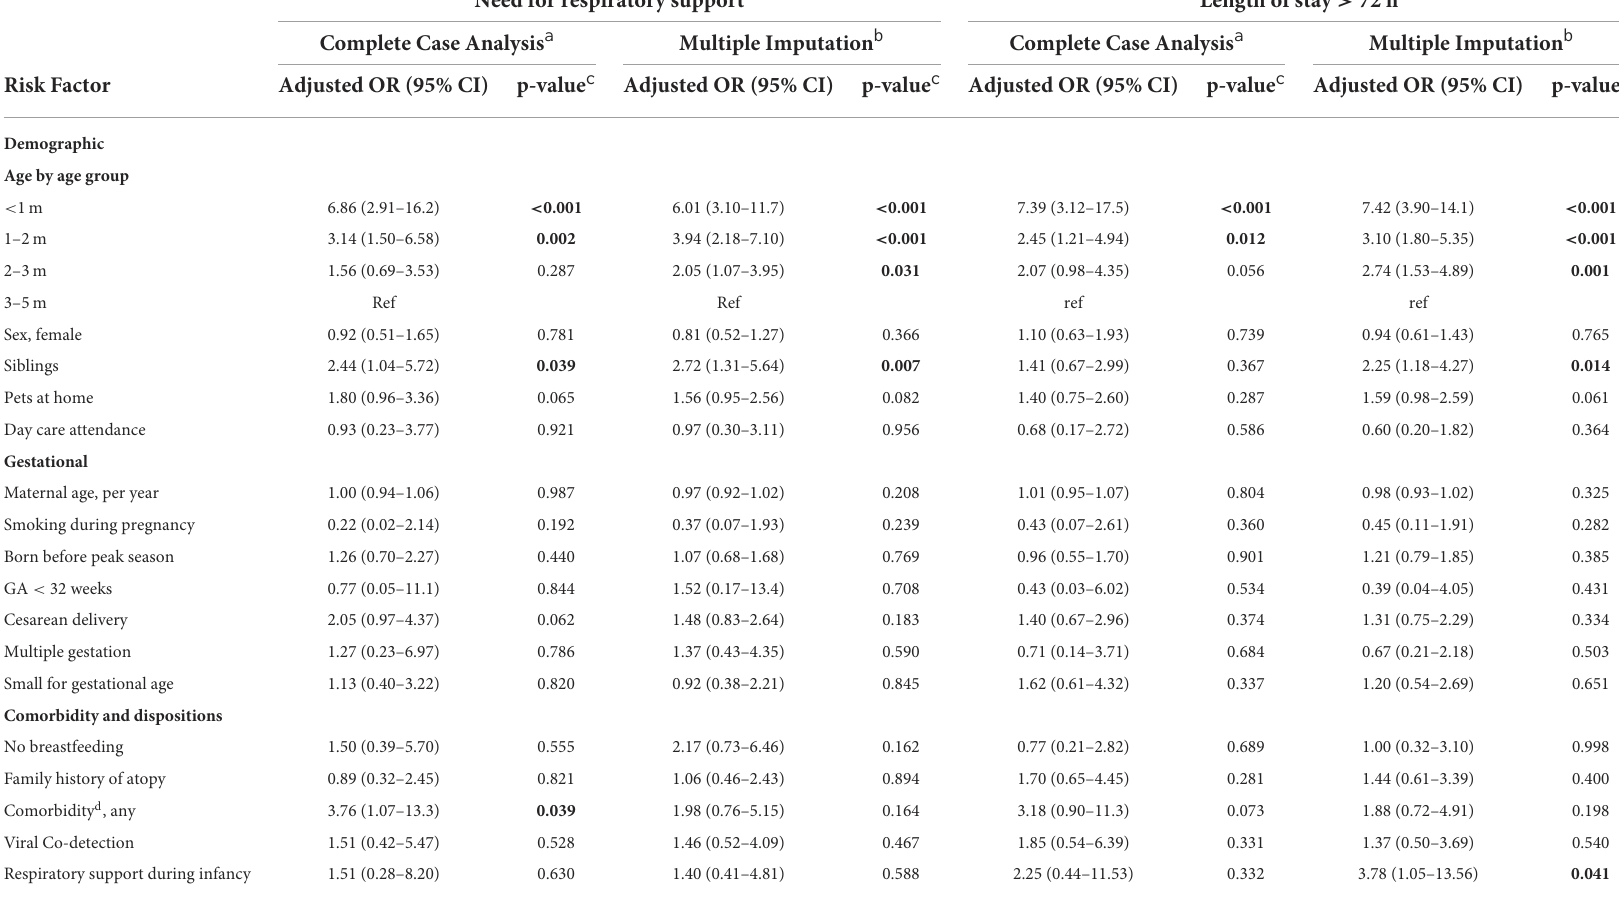
a Multivariate logistic regression analysis including all co-variates listed in the table. A total of 399 cases had complete data in all covariates. b Multiple logistic regression analysis after multiple imputation of missing data. Analysis includes all 1096 RSV cases. c Results significant at a level of 0.05 in bold text. A total of 16 associations are explored in this table, a Bonferroni-correction for test multiplicity suggests a level of significance at 0.05/16 = 0.003. d Comorbidity includes congenital heart disease,